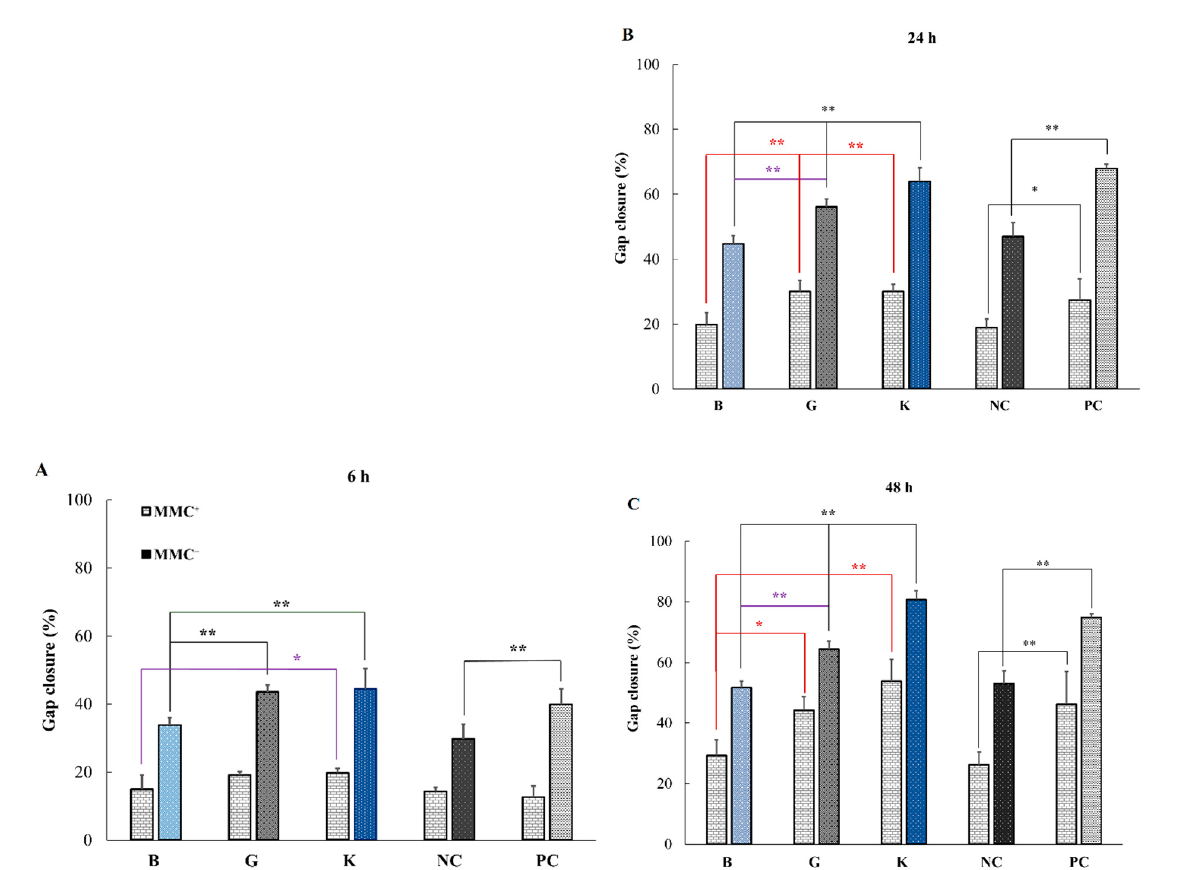
Figure 6. Effect of the addition of 0.1% HA on the migration of HaCaT cells towards gap closure with/without MMC in the wound scratch assay after 6 h ( A ), 24 h ( B ) and 48 h ( C ) using HA-B (8 kDa), -G (987 kDa) and -K (2290 kDa). Data are expressed as percentage of scratch wound healing area (mean ± SEM, n = 5, * p < 0.05, ** p < 0.01, Dunnet test). Table 2. Significant level for HaCaT migration assay, in presence of mytomycin ( n = 5,